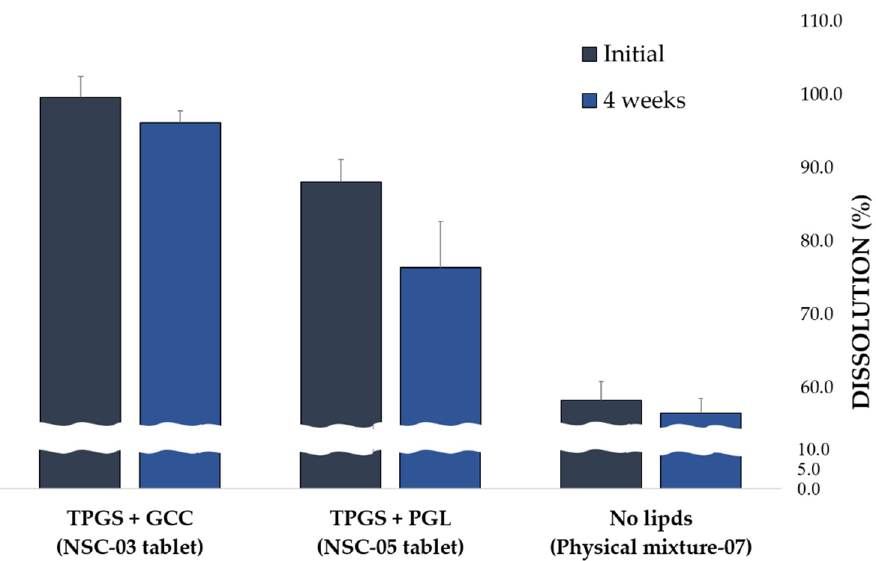
Figure 6. Dissolution rate of dutasteride in different NSC tablets (according to lipid combination) at 30 min from the start of dissolution and after stress test at 60 ± 2 °C for 4 weeks. 30 min from the start of dissolution and after stress test at 60